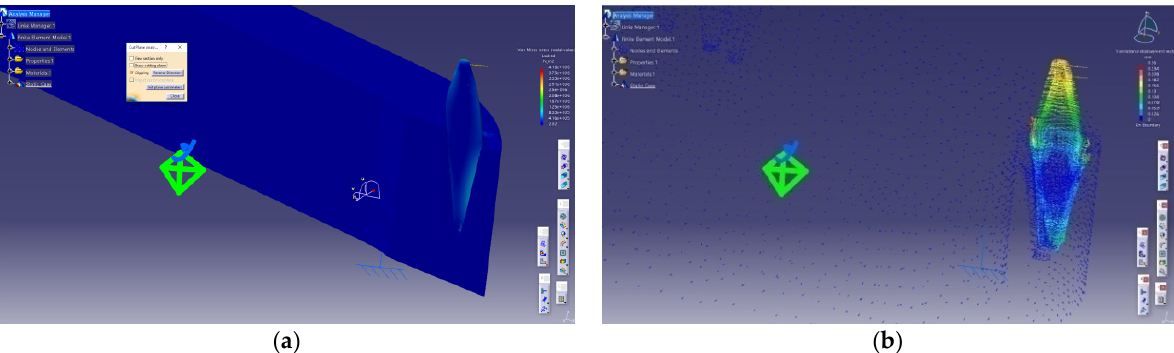
Figure 8. Lingualization of the LLI using a 1 N force: ( a ) von Mises tensions, no HBL; ( b ) tooth movement obtained, no